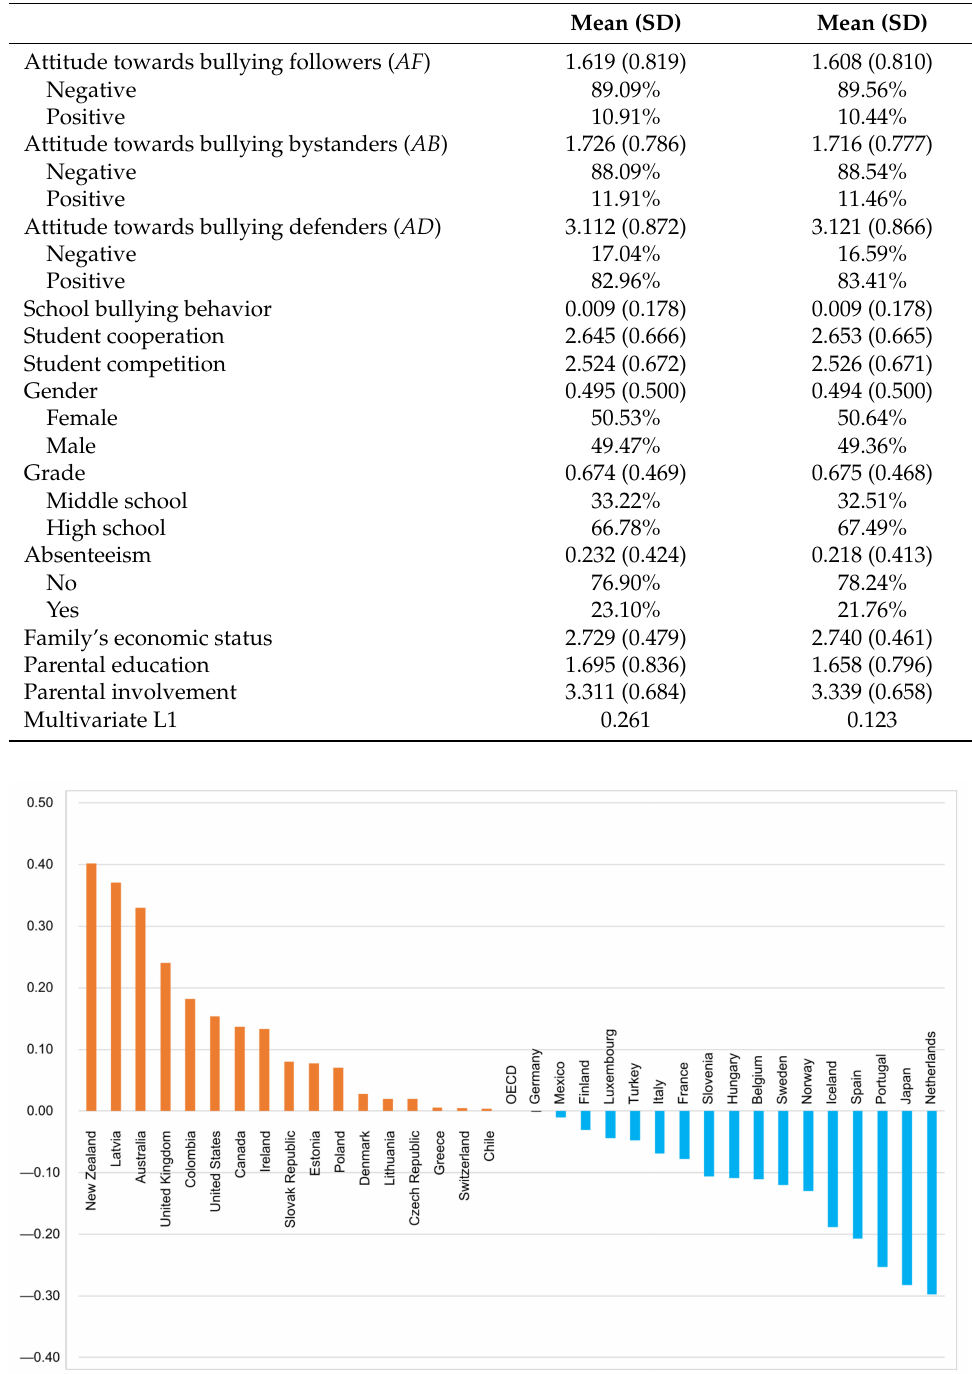
Figure 1. Index of exposure to bullying in 2018 among 34 OECD